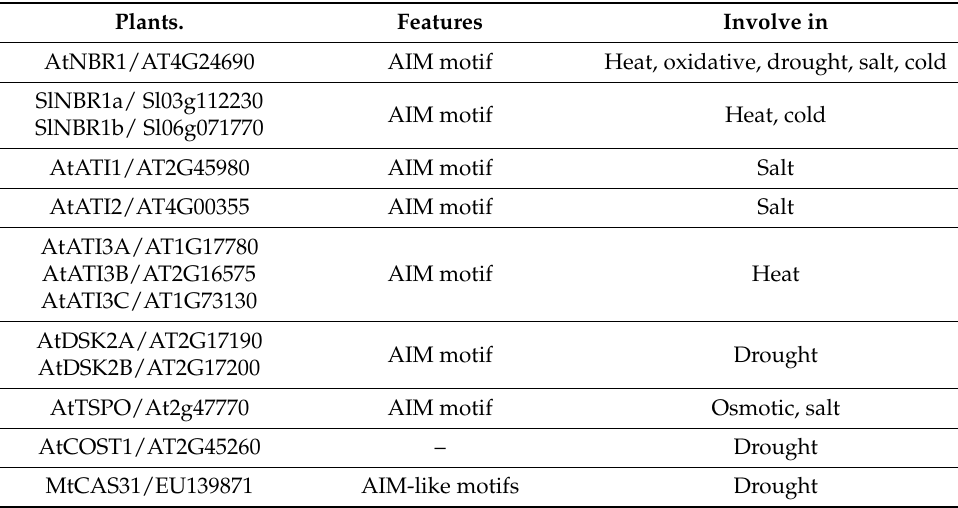
Table 1. The cargo receptors/adapters in plant abiotic stress responses. Plants. Features Involve in AtNBR1/AT4G24690 AIM motif Heat, oxidative, drought, salt, cold AIM